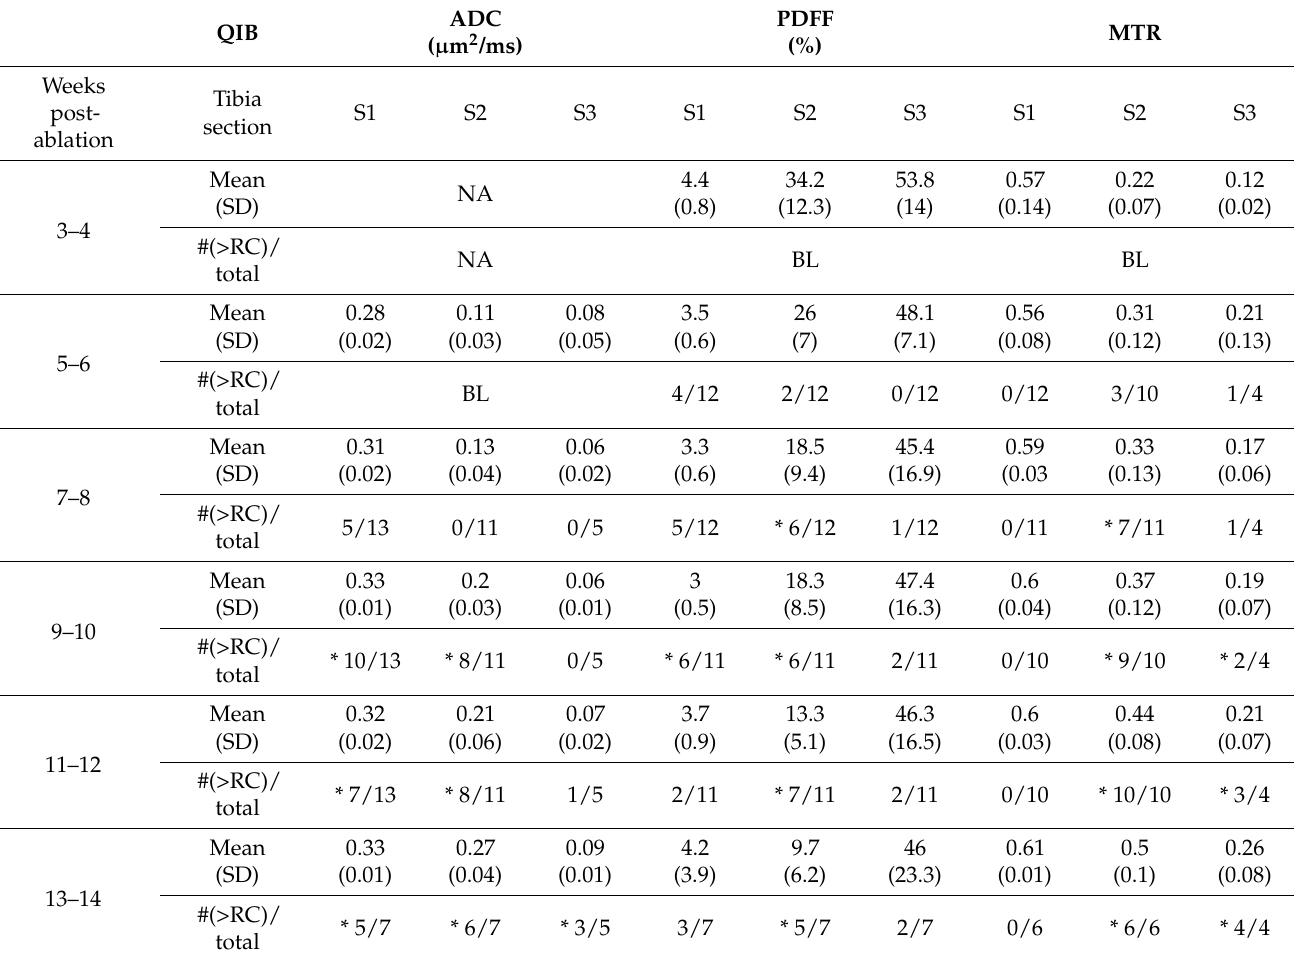
Table 3. Mean and SD QIB values for 13 diseased animals that had longitudinal imaging starting 3–4 weeks after bone marrow